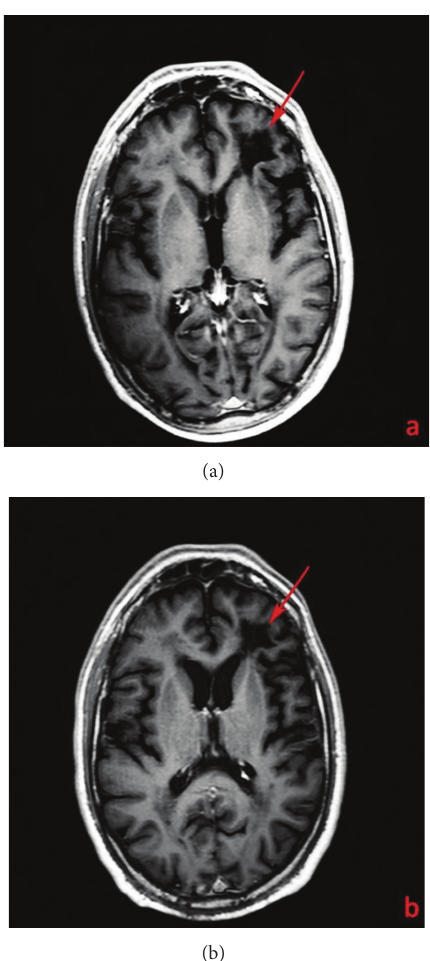
Figure 2: T1 post-Gd images (Philips Achieva 3T, TR/TE = 500 msec./14msec, 15cc Gadobenate Dimeglumine, Multihance) in December 2011 (a) and May 2012 (b) of the white matter lesion underneath the frontal lobe of the left hemisphere (arrows) without detectable contrast enhancement in a 44-year-old man with a 12- year history of MS affected by natalizumab-related PML.